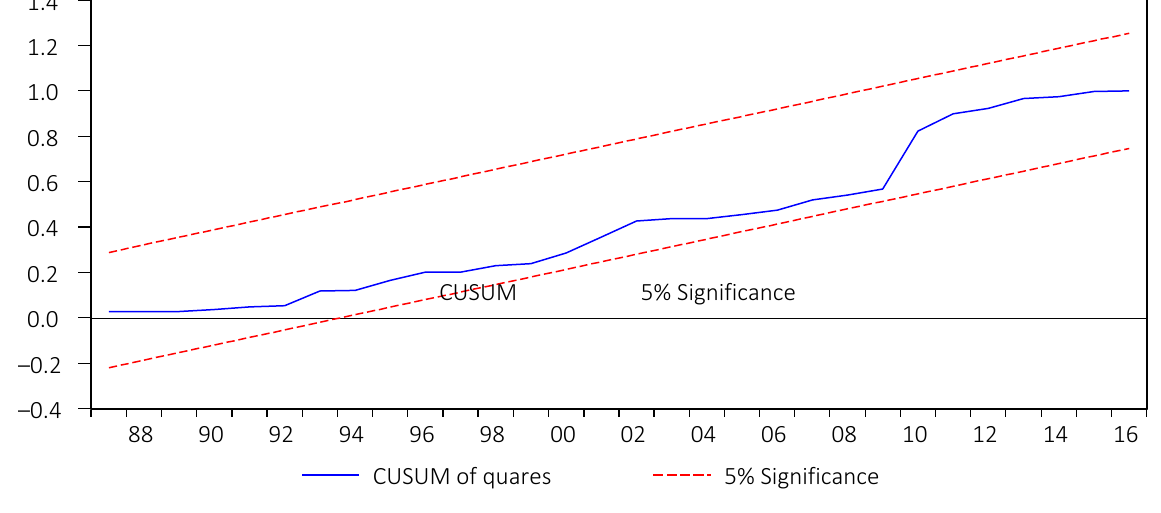
Figure 2. CUSUMSQ stability